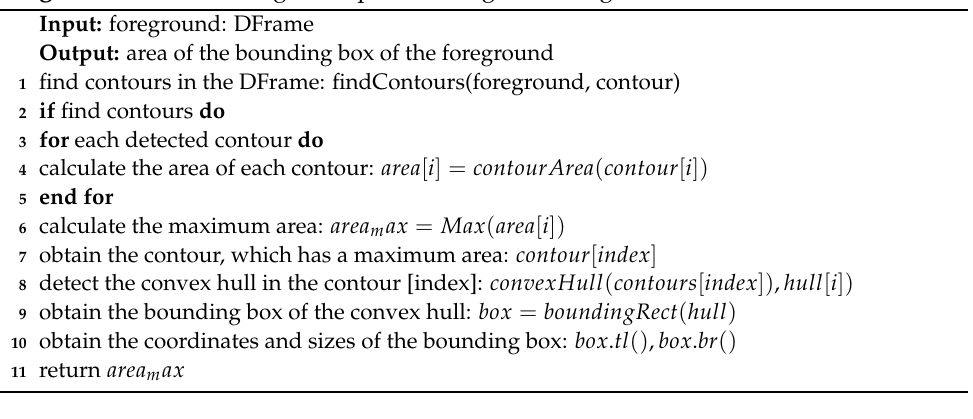
Algorithm 2: Positioning the captured foreground target.